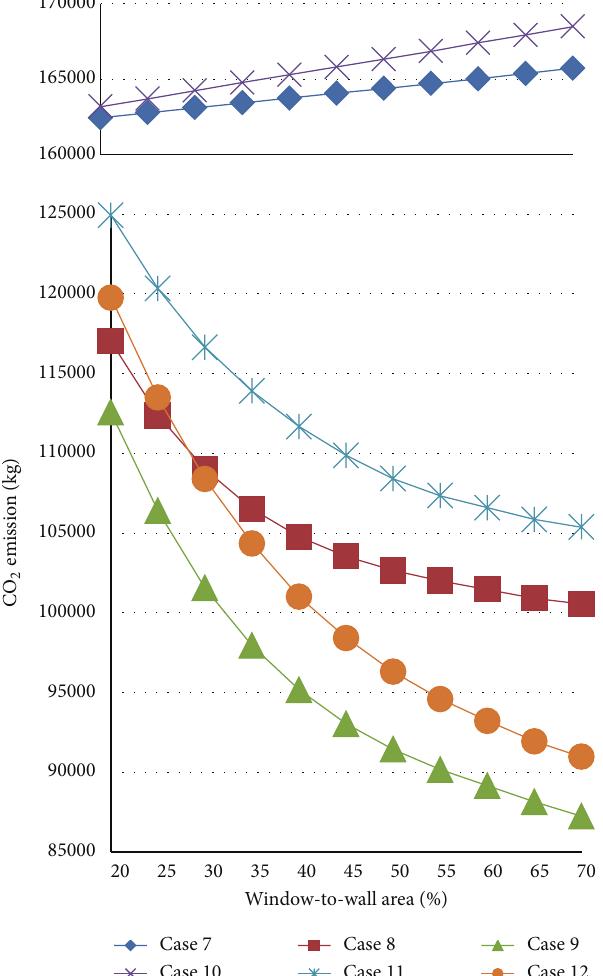
Figure 7: Results for cases 7–12.